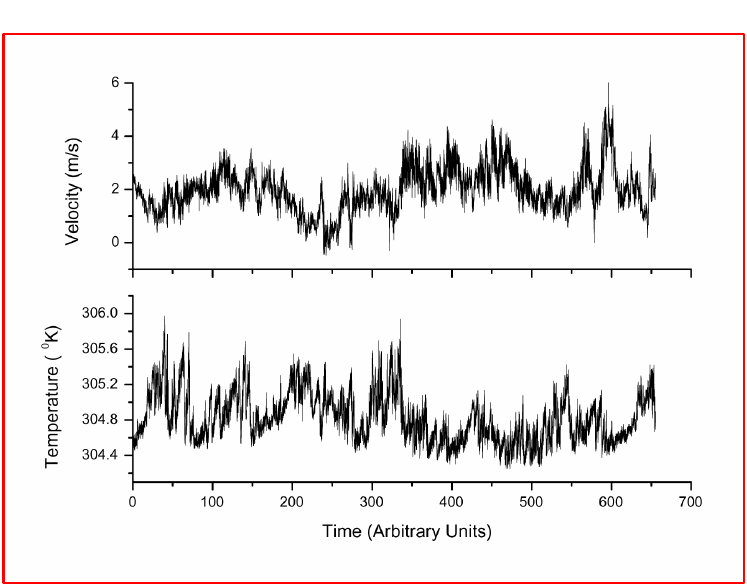
Figure 8: Turbulence as measured in the atmospheric boundary layer. Time evolution of the longitudinal velocity and temperature are shown in the upper and lower panels, respectively. The turbulent samples have been collected above a grass-covered forest clearing at 5 m above the ground surface and at a sampling rate of 56 Hz (Katul et al. ,